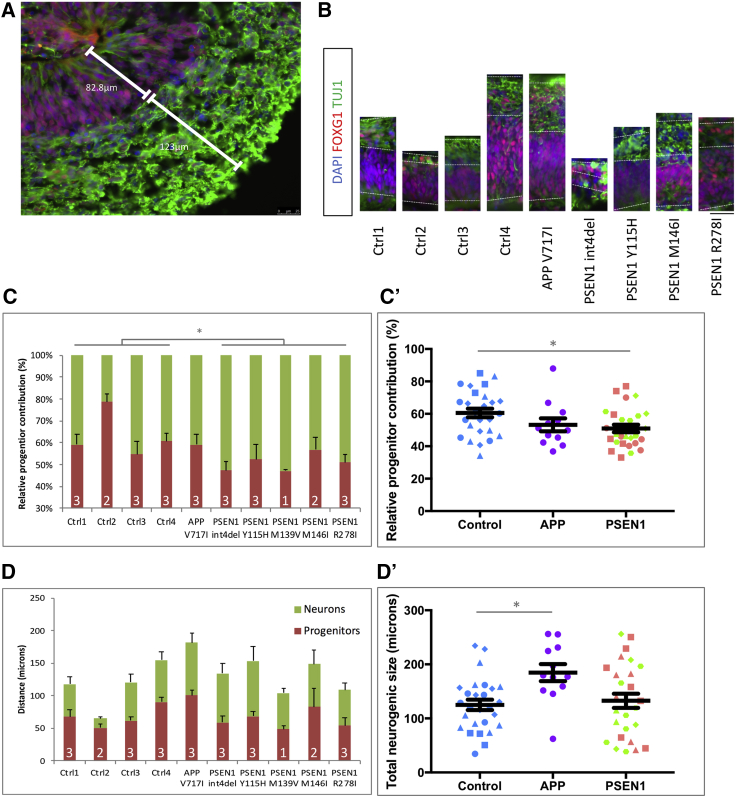
iPSC-Derived Cerebral Organoids Exhibit Premature Neurogenesis in PSEN1 Mutant Lines(A and B) Depictions of the relative contribution of proliferative progenitors (FOXG1+/TUJ1−) and committed neurons (TUJ1+) within the neurogenic niches of iPSC-derived cerebral organoids. Quantifications were made from the basement membrane to the neural boundary (in micrometers) in at least two neurogenic regions per organoid. (B) is to scale, and the scale bar represents 25 μm.(C) Quantification of the relative contribution of the neural progenitors and neurons for individual control, APP, and PSEN1 mutation lines. (C′) shows the same data grouped by genotype.(D) Quantification of the overall size of the neurogenic regions for each line (progenitor contribution plus neural contribution). (D′) shows the same data grouped by genotype.The number of independent organoid batches is shown within the histograms. ∗p < 0.05, ∗∗p < 0.01, ∗∗∗p < 0.001 via ANOVA with post hoc Tukey’s analysis, as indicated in Table S1. Ctrl1, blue circles; Ctrl2, blue squares; Ctrl3, blue triangles; Ctrl4, blue diamonds; APP V717I, purple circles; PSEN1 int4del, pink circles; PSEN1 Y115H, pink squares; PSEN1 M139V, green triangles; PSEN1 M146I, green diamonds; PSEN1 R278I, green hexagons. Error bars represent standard error of the mean.